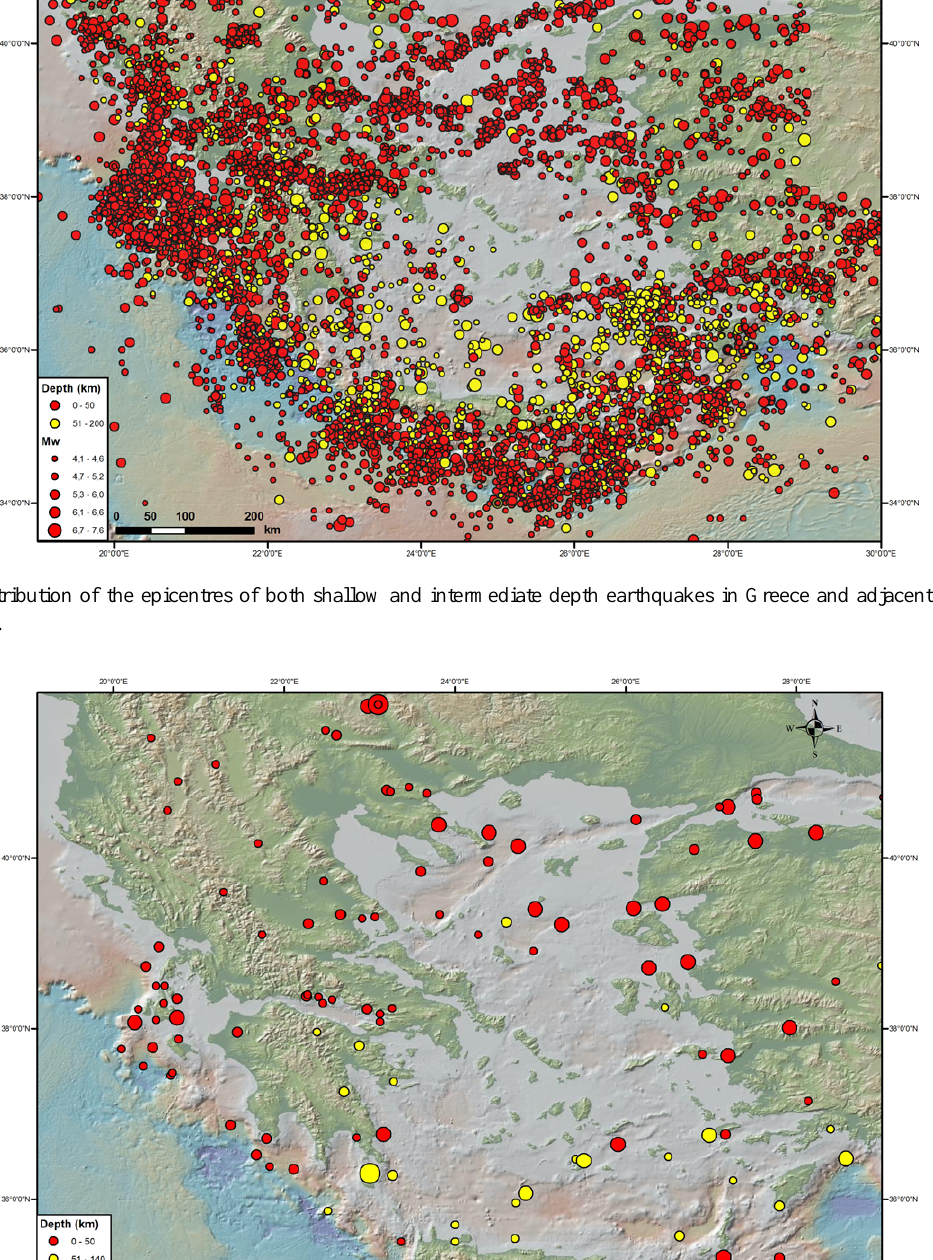
Nat. Hazards Earth Syst. Sci., 12, 1425–1430,